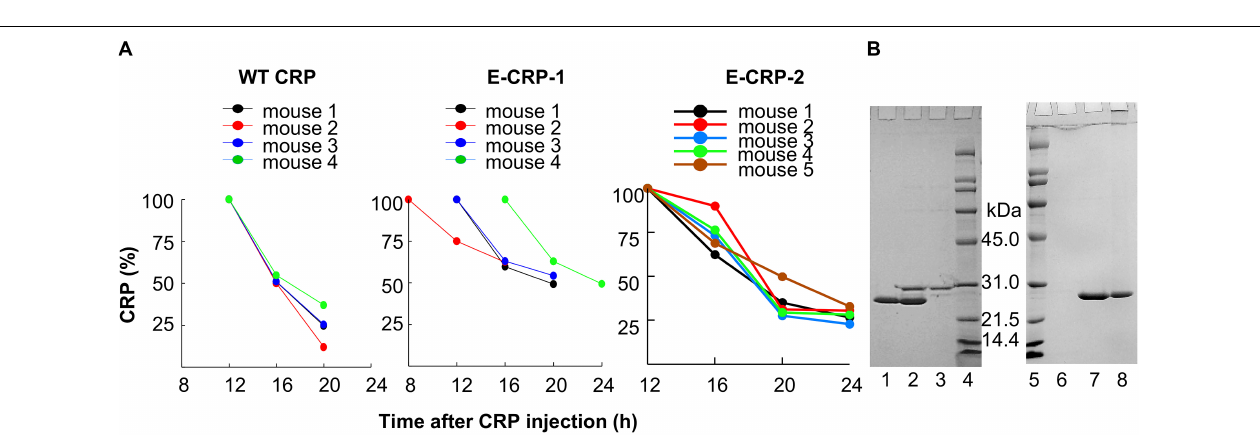
FIGURE 4 | E-CRP-1 and E-CRP-2 are suitable for in vivo use. (A) Clearance of WT CRP (left panel), E-CRP-1 (middle panel) and E-CRP-2 (right panel) from mouse circulation. (B) Repurification of E-CRP-1 and E-CRP-2 from purified E-CRP-1-spiked and E-CRP-2-spiked mouse sera, respectively. SDS-PAGE of repurified E-CRP-1 and E-CRP-2 is shown. Lane 1, purified E-CRP-1; Lane 2, EDTA eluate from the PEt-affinity chromatography column through which mouse serum containing E-CRP-1 was passed in the presence of Ca 2 + ; Lane 3, EDTA eluate from the PEt-column through which mouse serum alone was passed. Lane 6, EDTA eluate from the PCh-affinity chromatography through which mouse serum alone was passed; Lane 7, EDTA eluate from the PCh-column through which mouse serum containing E-CRP-2 was passed in the presence of Ca 2 + ; Lane 8, purified E-CRP-2.